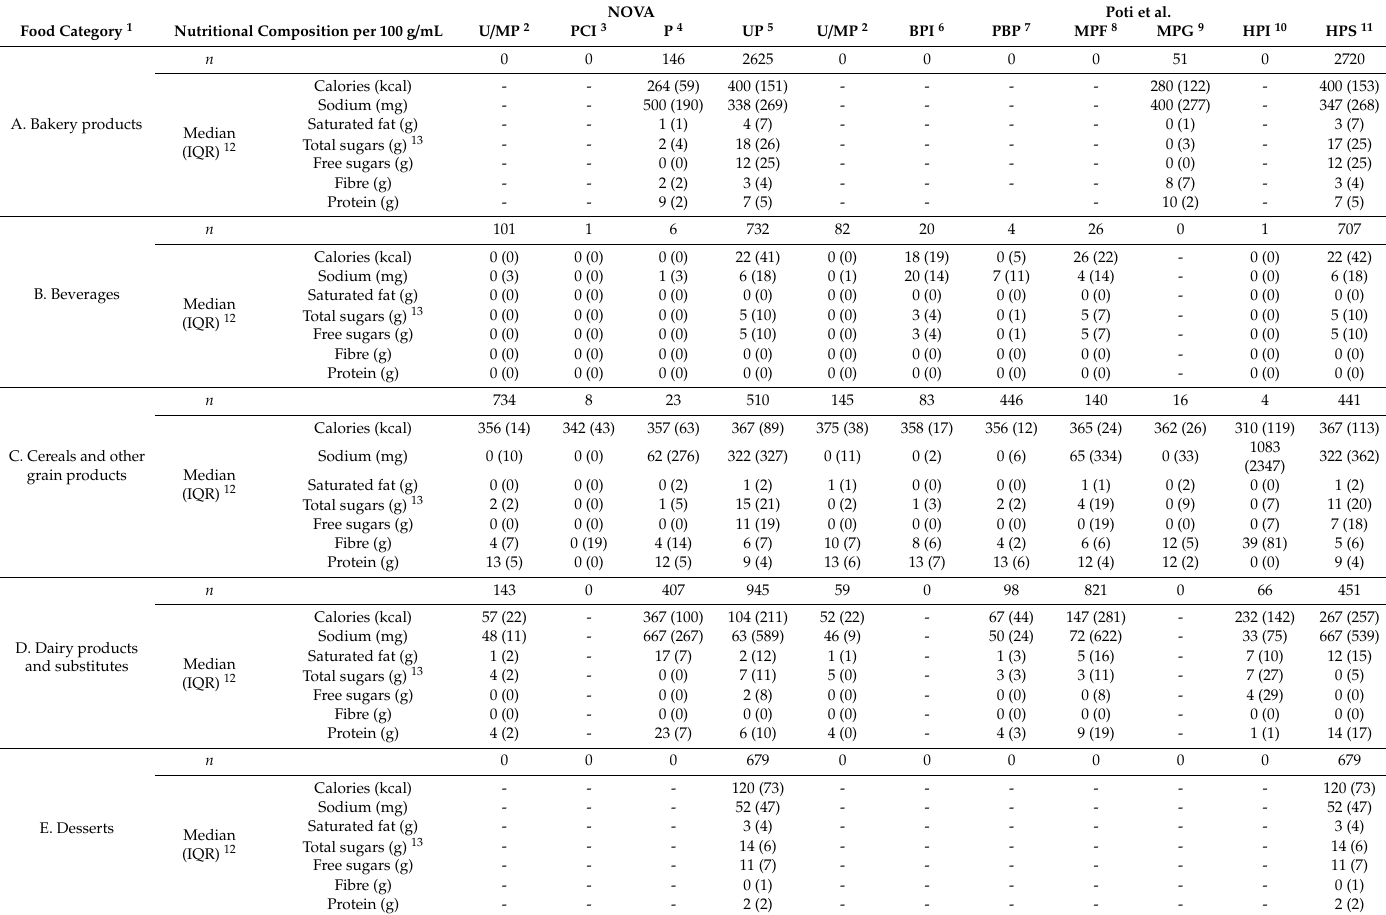
Table 4. Median amounts of calories, sodium, saturated fat, total sugars, free sugars, fibre and protein per 100 g (or 100 mL) for products in each processing classification of the NOVA and Poti et al. systems, presented by food category 1